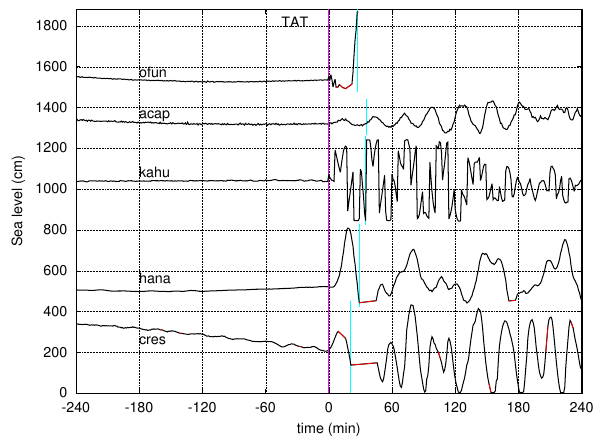
Fig. 3b. Examples of complete and incomplete records. Records are not detided and are aligned starting from TAT. The end of the first wave is indicated with a light blue line. Filled data are in red. The record of Acapulco, Mexico (acap) does not give any interpretation problem since it has no gaps and no saturation. The record of Kahu- lui, Maui island, Hawaii (kahu) presents saturation in the negative level during the first wave oscillation, and later also for positive os- cillations. The records of Hanasaki, Japan (hana) and of Crescent City, California (cres), show substantial data gaps that make it dif- ficult to estimate both period and amplitude of the first wave. Ofu- nato, Japan (ofun), gives an example of a suddenly truncated record, since the tide gauge was broken by the violence of the wave. It also shows some gaps just before the large peak. The first anomaly prob- ably refers to direct seismic effects rather than tsunami. Estimates from incomplete records are considered uncertain.